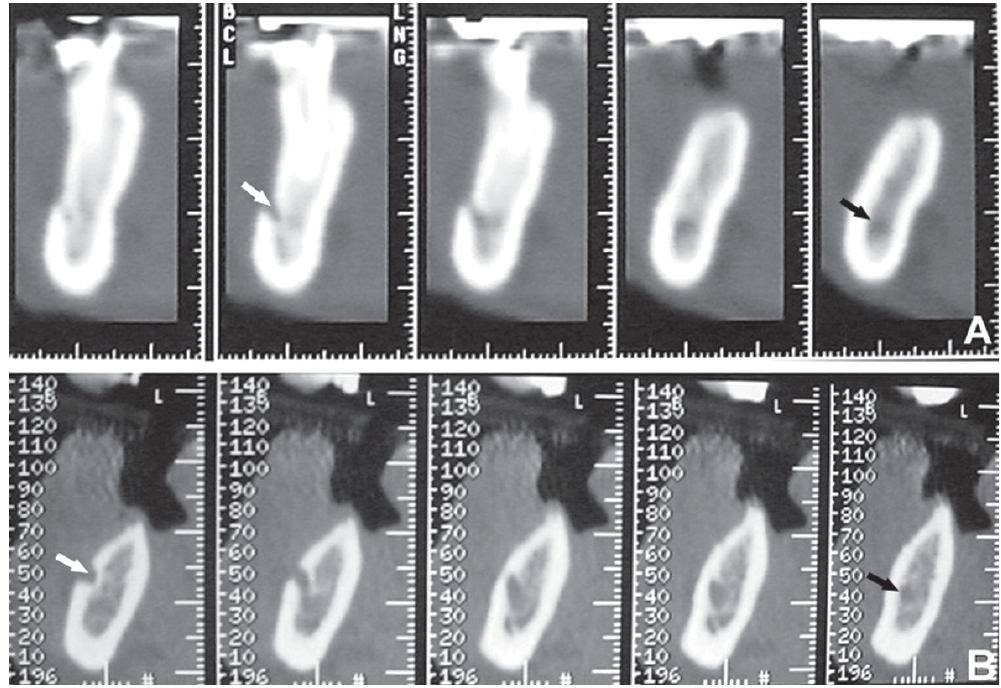
FIGURE 1- A. Single-slice CT cross-section of the mandible. B. Multislice CT showing better depiction of the anatomical landmarks (white arrows – mental foramen opening; black arrows – mandibular canal)